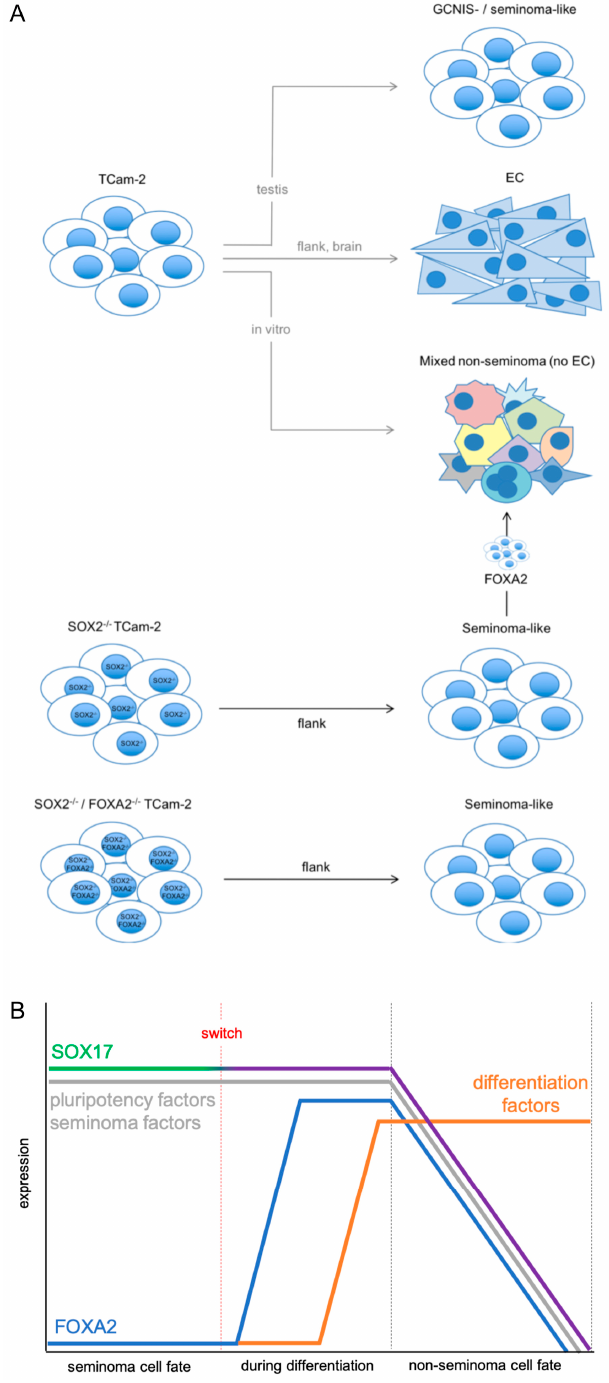
Figure 5. ( A ) Model summarizing the influence of the microenvironment on the cell fate of TCam-2 cells and the role of SOX2 and FOXA2 in these processes (based on [9]). ( B ) Illustration of the molecular effects associated with the switch of SOX17 from a pluripotency to a differentiation-inducing factor during in vivo growth of TCam-2- Δ SOX2 .